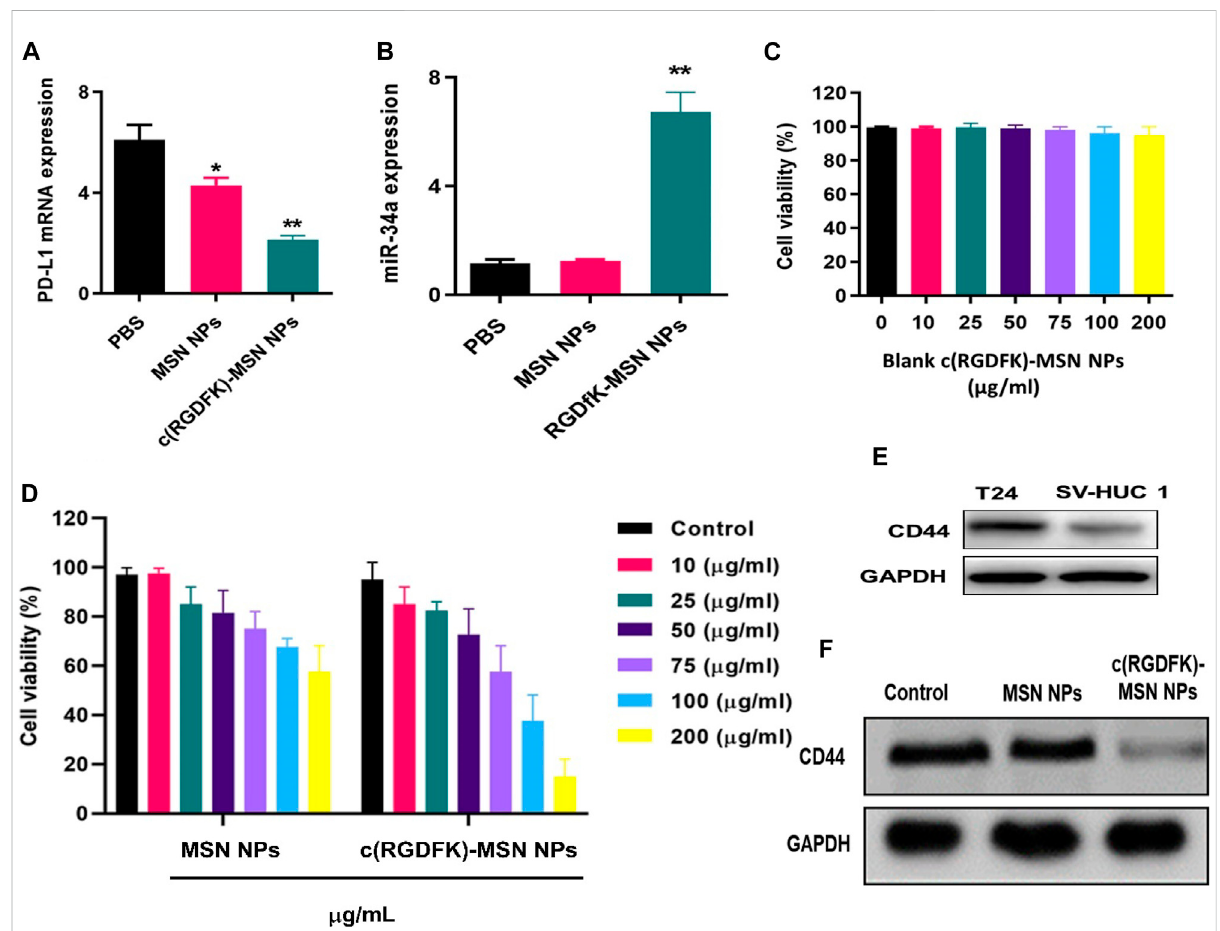
FIGURE 5 Effectsofc(RGDfK)-MSNsNPsonthecytotoxicityofT24cellline. (A) ExpressionofPD-L1inT24cellsafterincubationwithc(RGDfK)-MSNsNPs and MSN NPs for 24 h. (B) Expression of miR-34a in T24 cells after incubation with c(RGDfK)-MSNs NPs and MSN NPs for 24 h. (C) Cytotoxicity of blank c(RGDfK)-MSNs NPs detected by MTT assays. (D) Cytotoxicity of T24 cells after incubation with different concentrations of c(RGDfK)-MSNs NPs and MSN NPs for 24 h. (E) Expression of CD44 protein in T24 and SV-HUC 1. (F) Expression of CD44 protein in T24 cells after